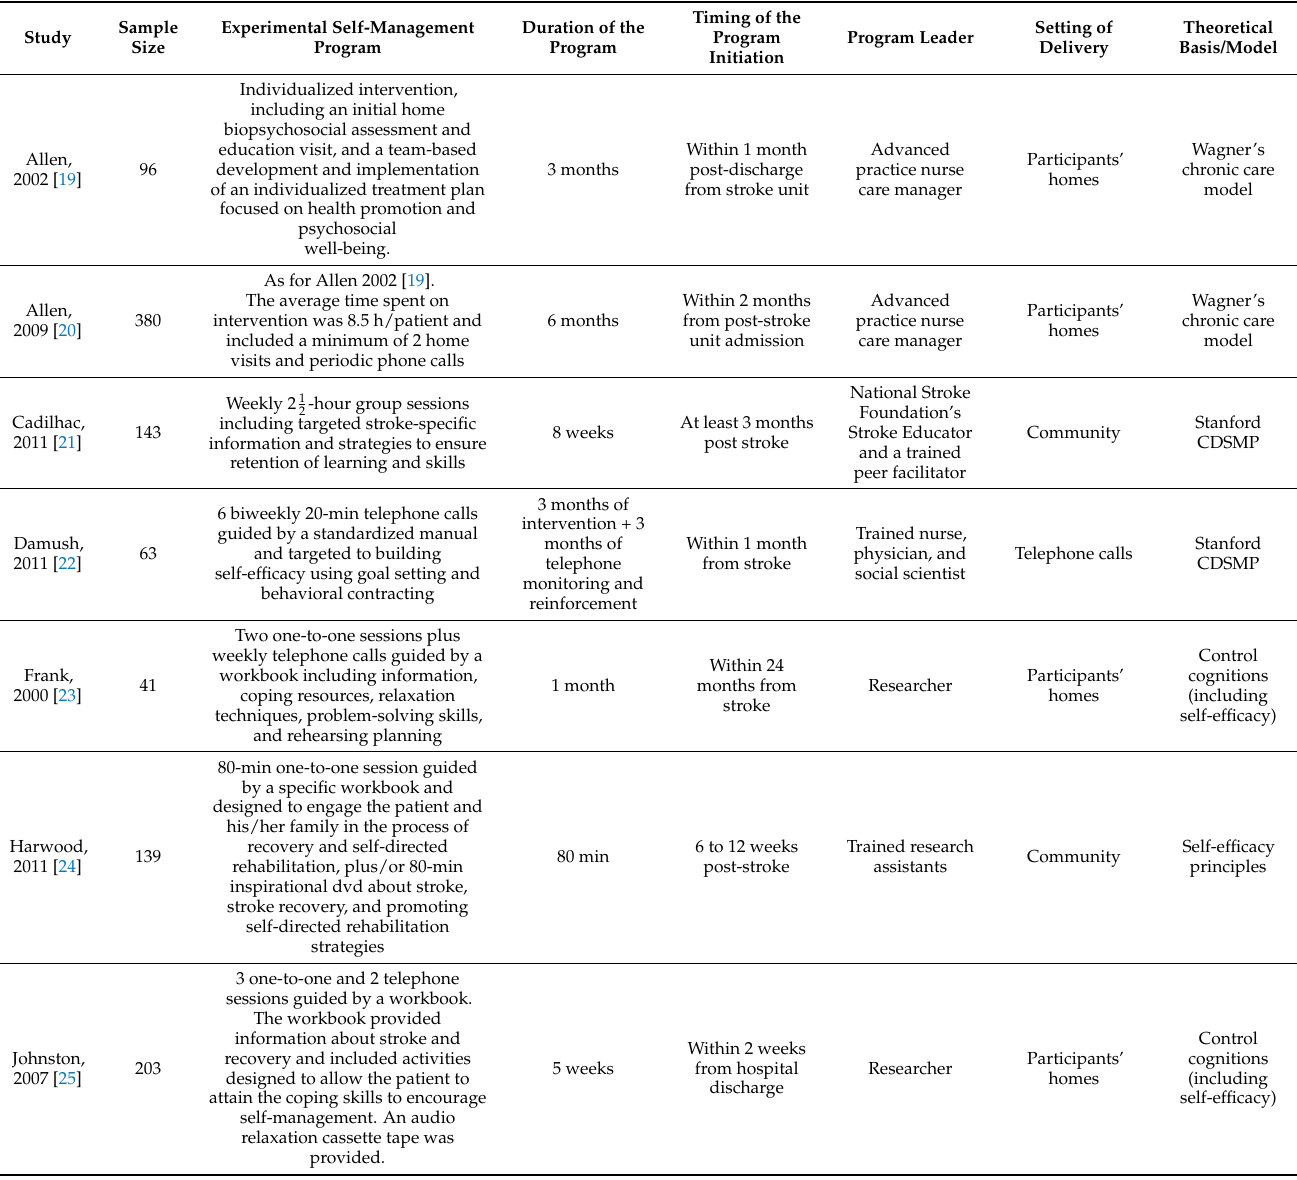
Table 1. Characteristics of the randomized controlled trials that informed the LAY